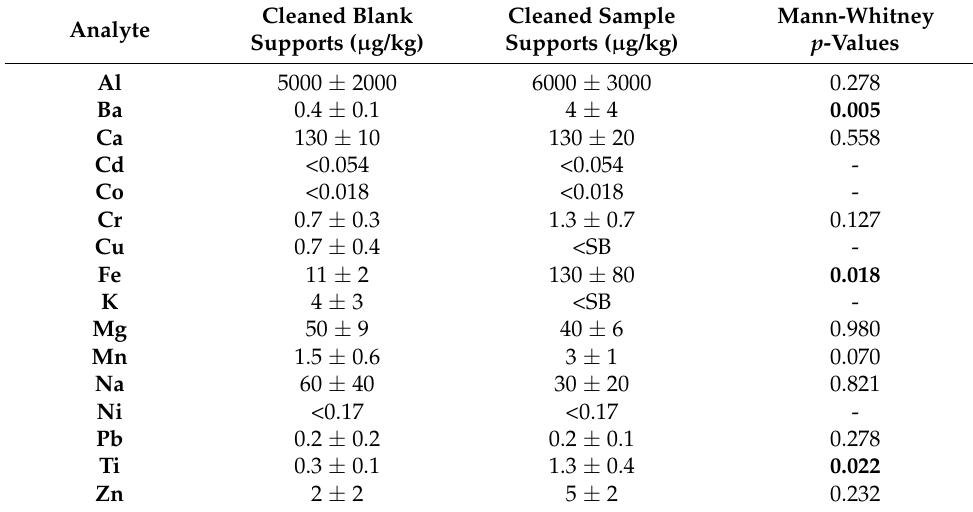
Table 5. Concentrations of analytes in cotton wads used for further wiping of blank aluminium supports and of aluminium supports after removal of samples (oven digestion); p -values obtained with Mann–Whitney test ( p -values lower than 0.05 are in bold) for verifying if the removal of samples from aluminium foils was